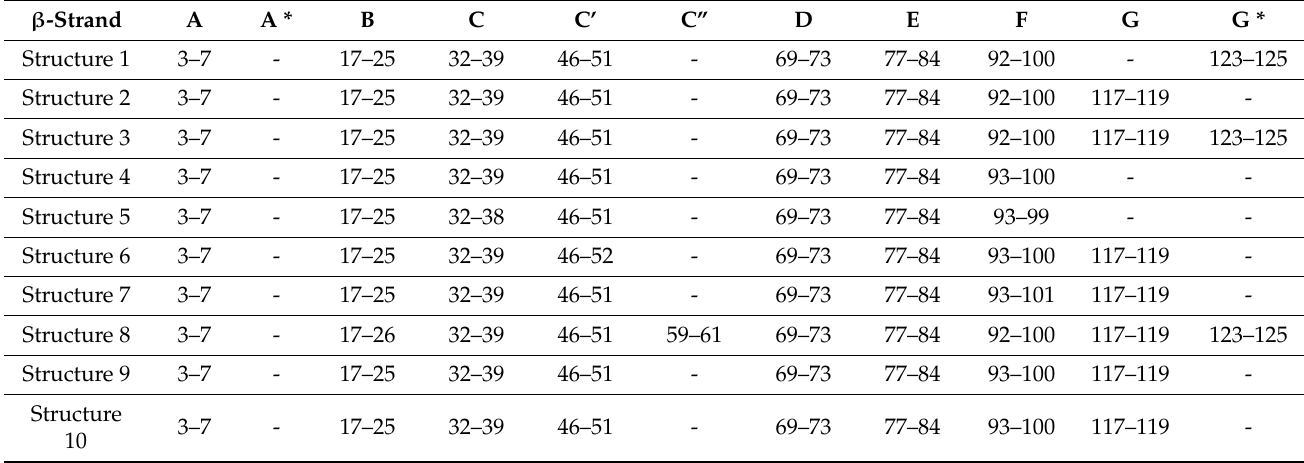
Figure 5. ( a ) An overlay of the Nb23 backbone of the NOE-restrained best cluster. The C α − RMSD with respect to the best structure was 1.57 ± 0.32 Å, with substantial conformational dispersion localized in the CDR3 (highlighted in red). By excluding the CDR3 and residues 1, 2, and 129 from the alignment, the C α − RMSD was 1.23 ± 0.30 Å. ( b ) An overlay of the Nb23 backbone of the CS − Rosetta ensemble. The C α − RMSD with respect to the lowest energy structure was 3.42 ± 2.12. By excluding the CDR3 (highlighted in blue), the C α -RMSD was 1.53 ± 0.99 Å, calculated over the fragments 1 − 102, 117 − 122. The conformational dispersion at the CDR3 is much more pronounced than the spread of the corresponding region in the NOE-restrained best cluster. ( c ) A visualization of the positions of the β − strands, lettered in white or grey. The only whole strand missing (C”) is highlighted in red, and protein terminals in black. Table 3. β -structure content of the calculated Nb23